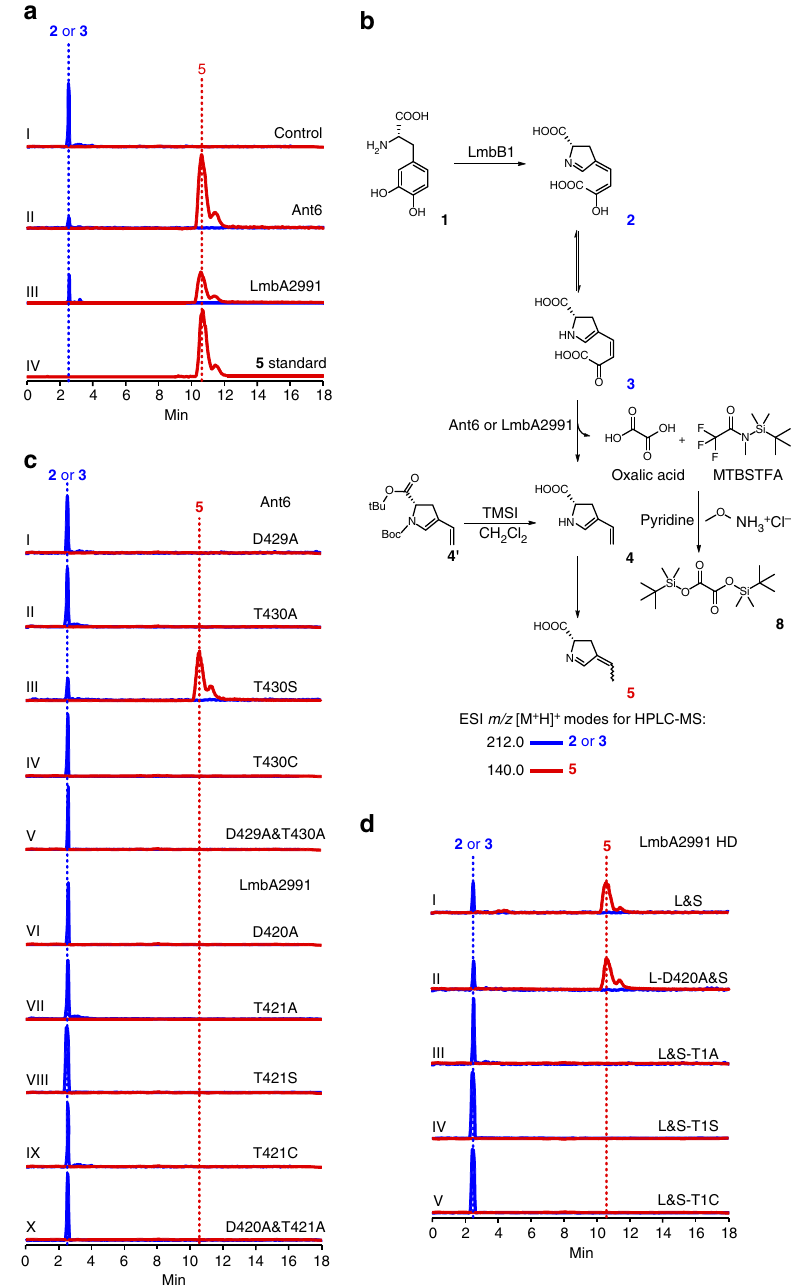
Figure 5 | Examination of Ntn-hydrolase activity by HPLC-ESI-MS analysis. Pyrroline substrate ( 2 or 3 ) was prepared in situ through LmbB1-mediated transformation of L -DOPA during the conversion to diene product ( 5 ) in the absence or presence of the catalysts. ( a ) Validation of Ntn-hydrolase activity of Ant6 and LmbA2991. I, negative control (without the catalyst Ant6 or LmbA2991); II, Ant6; III, LmbA2991 and IV, 5 standard. ( b ) Production of imine diene 5 through the tautomerization of enamine diene 4 , which results from either LmbB1 and Ant6 (or LmbA2991)-mediated cascade transformations (the derivatization of the co-product oxalic acid is indicated) or chemical deprotection of the synthesized mimic 4 0 . ( c ) Evaluation of self-activation dependence for Ntn-hydrolase activity of Ant6 and LmbA2991. I, Ant6-D429A; II, Ant6-T430A; III, Ant6-T430S; IV, Ant6-T430C; V, Ant6- D429A&T430A; VI, LmbA2991-D420A; VII, LmbA2991-T421A; VIII, LmbA2991-T421S; IX, LmbA2991-T421C and X,